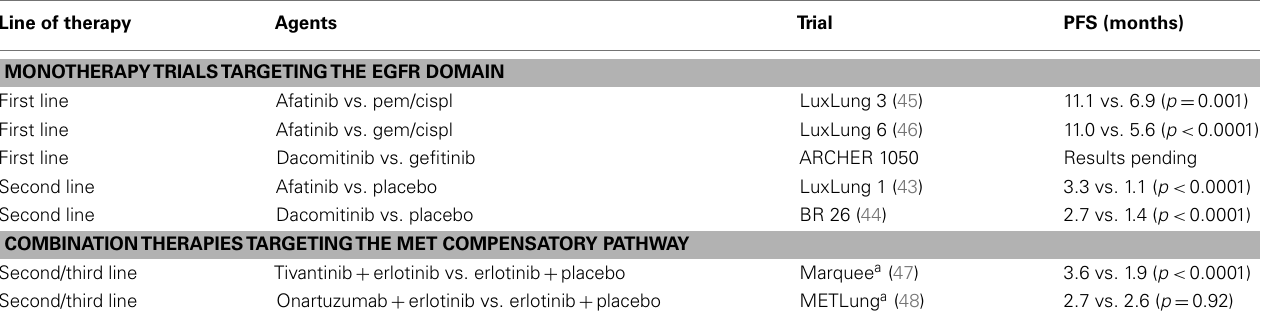
Table 2 | Select trials addressing acquired resistance to targeted therapy